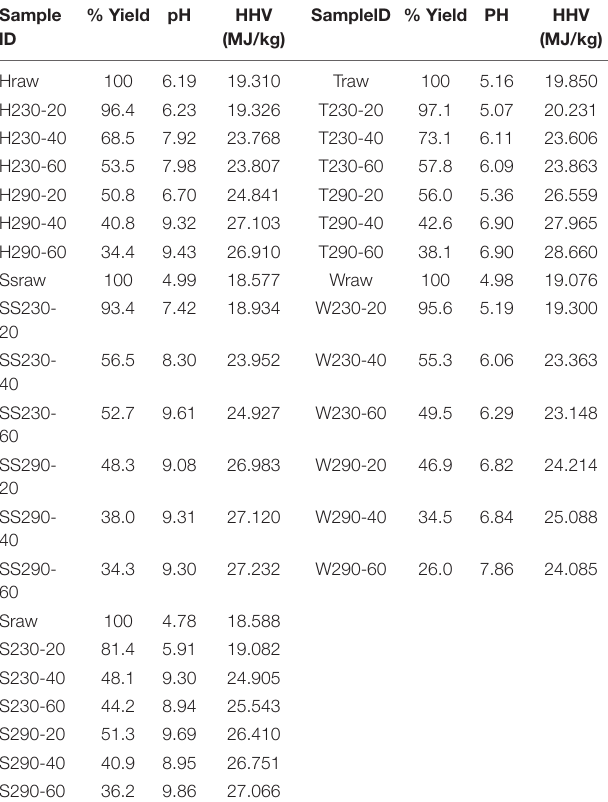
TABLE 2 | Yield, pH, and higher heating value (HHV) for raw and treated biomass